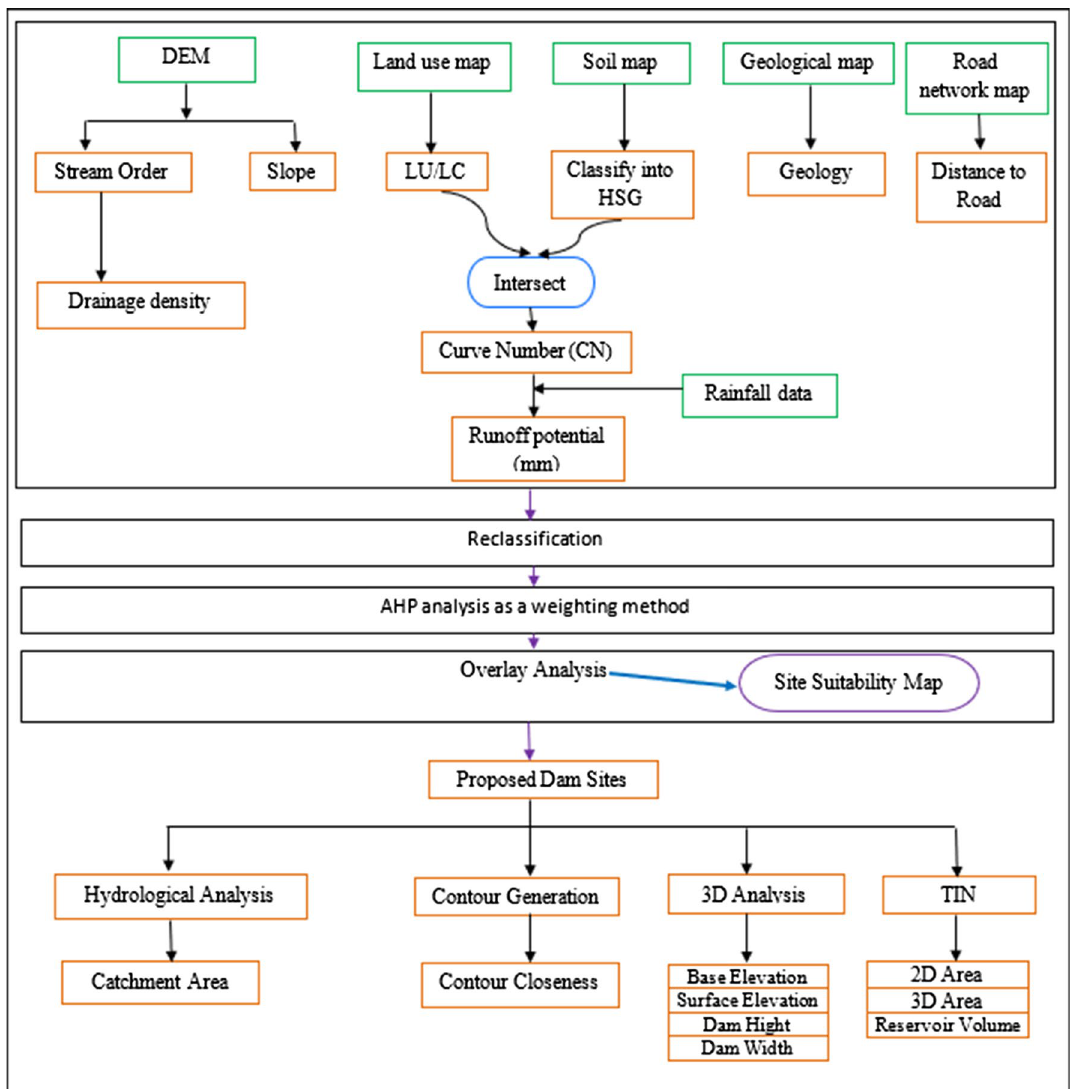
Fig. 2 Workflow of this